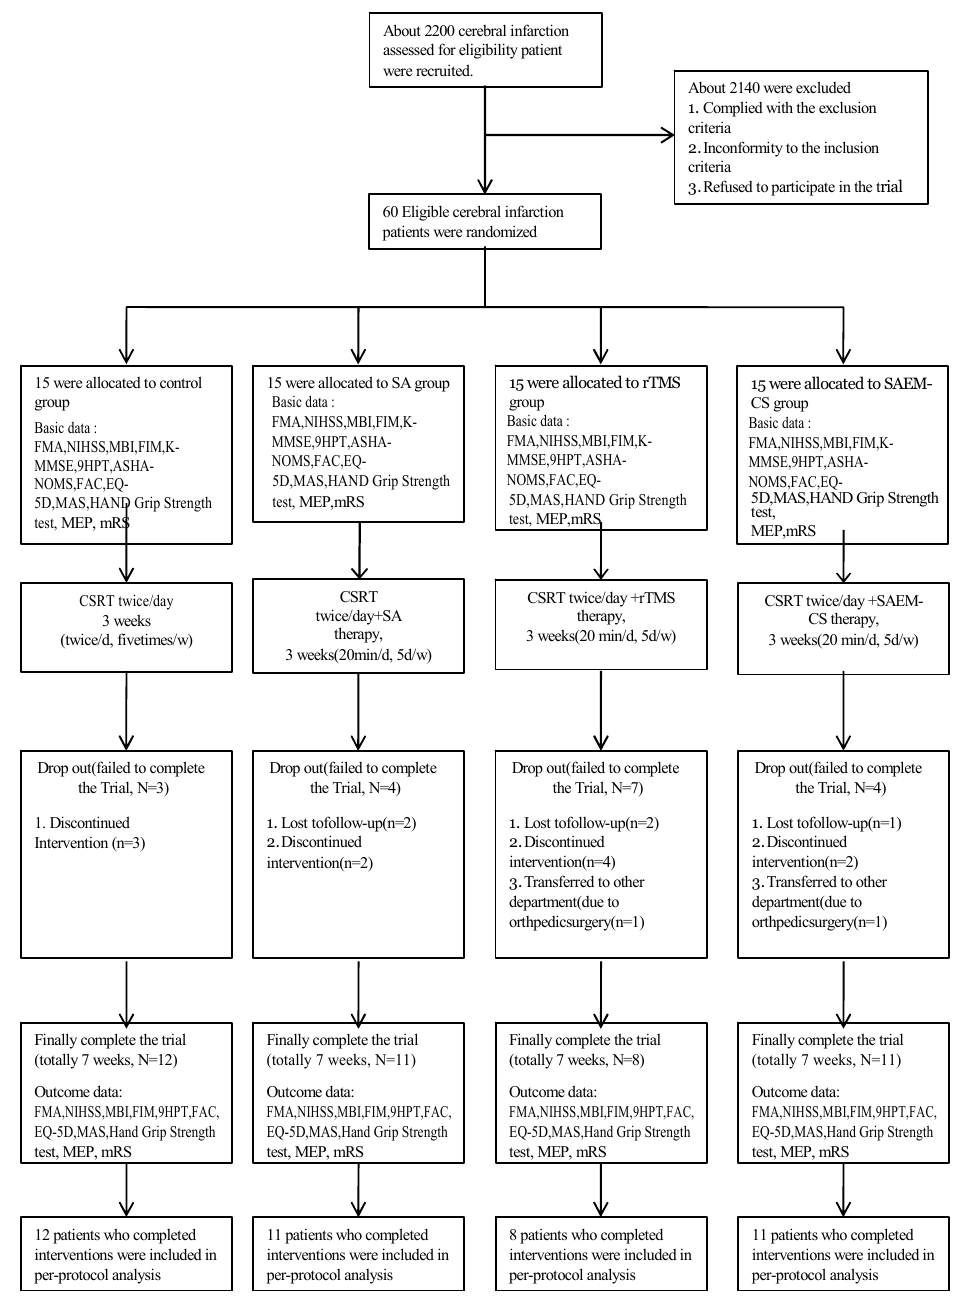
Figure 1. The flow of participants through the trial and the reasons for participant dropout are shown.